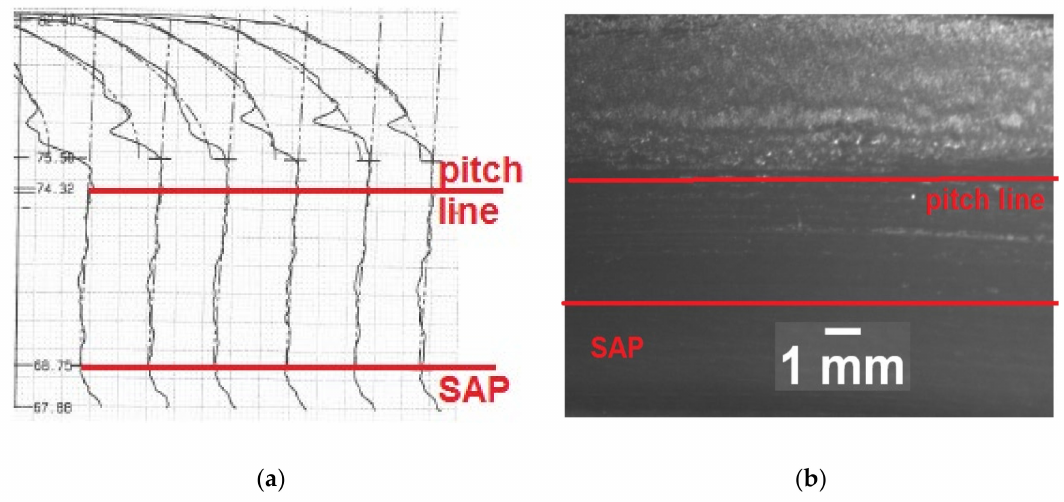
Figure 3. Micropitting on a pinion of test gears ( a ) Measurement data from gear measurement machine, ( b ) Optical image of the pinion flank